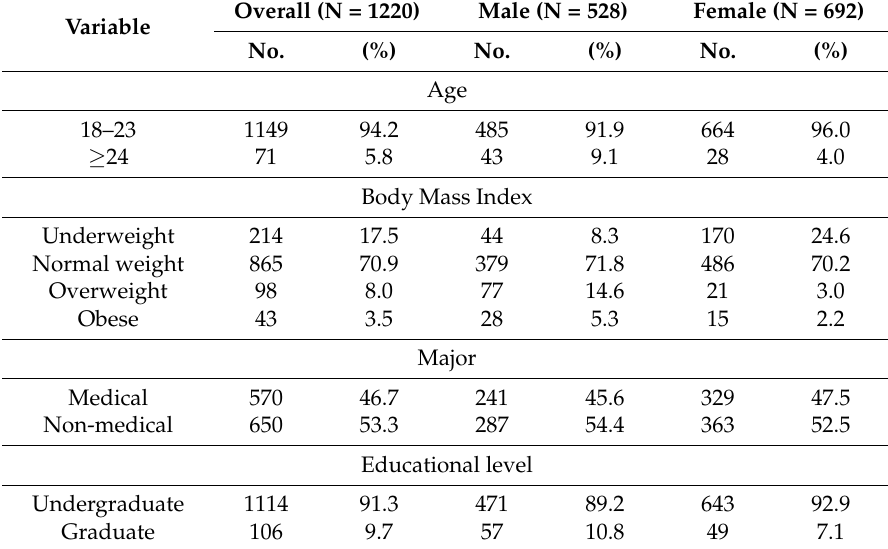
Table 1. Basic information for the study population. BMI: body mass